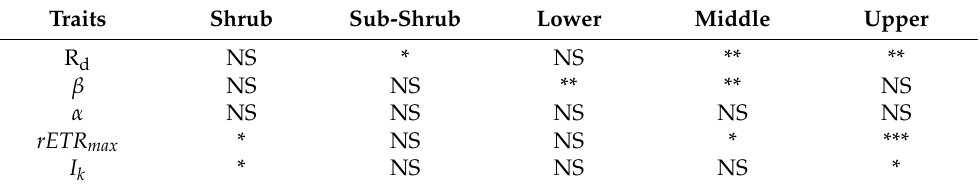
Table A7. The results of one-way analysis of variance (ANOVA) of functional trait differences between different parts of the tree canopy within five different height ranges.